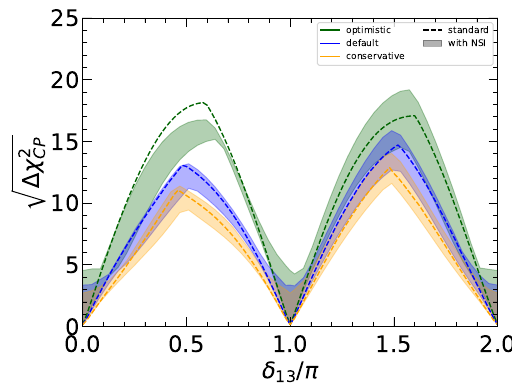
Figure 3 . The impact NSI could have on the measurement of CP violation at ESS ν SB for different choices of systematic uncertainties. The bands result from varying φ eµ in the fake data. The dashed lines, corresponding to the standard analysis without NSI, are the same as in figure 1 for the analysis with two detectors and NC